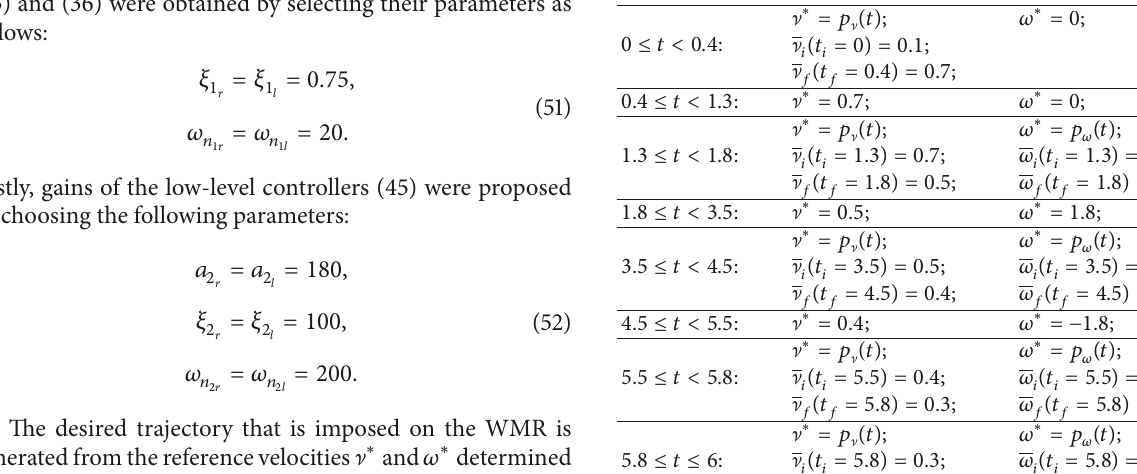
Table 1: Desired trajectory defined by B´ezier polynomials.